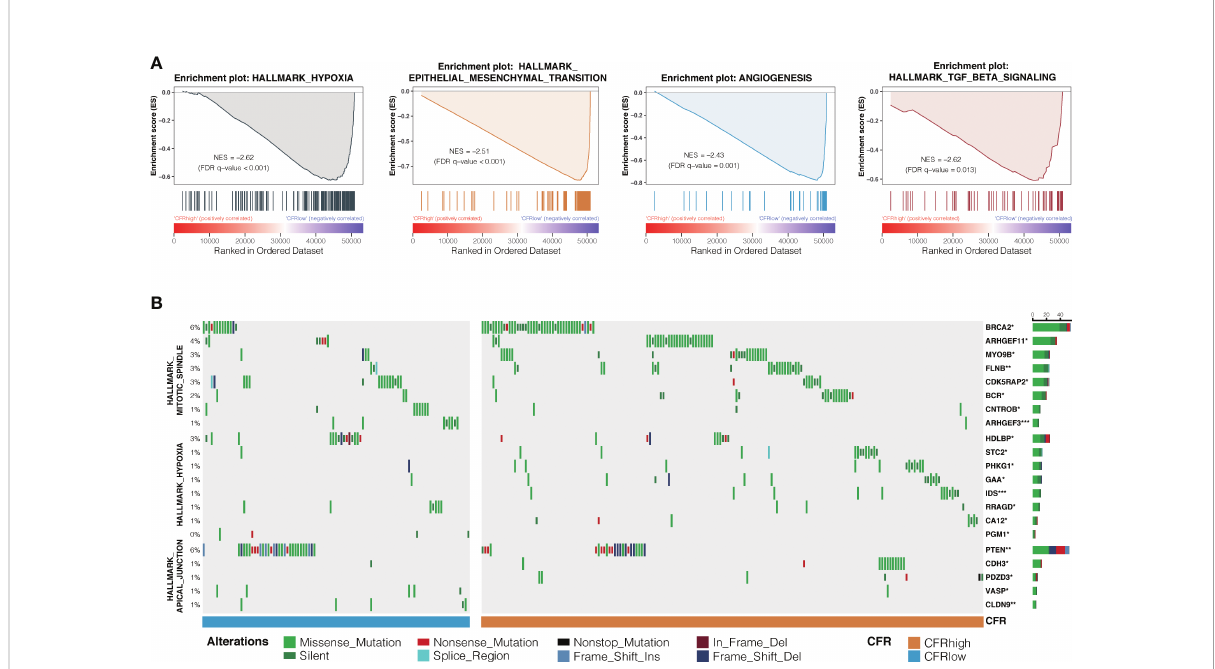
FIGURE 6 Differences in signaling pathways and genes between CFR subgroups. (A) Prominent enrichments of signatures in CFR high vs. CFR low groups. FDR, false discovery rate. (B) Mutation enrichment characteristics among subgroups. A group of genes signi fi cantly more mutated than the other groups are displayed (Fisher ’ s test, * p < 0.05, ** p < 0.01, ***, p < 0.001) display the top 20 most signi fi cant